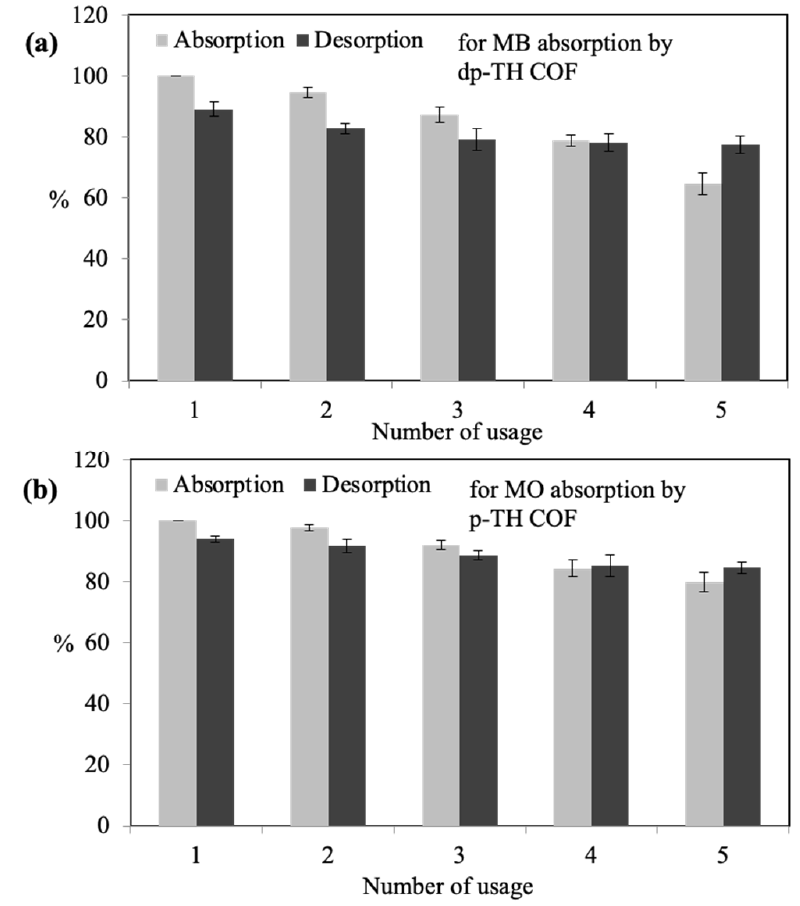
Figure 6. Reusability studies of ( a ) MB absorption/desorption by dp-TH COFs, and ( b ) MO absorption/desorption by dp-TH COFs. (Reaction conditions: 100 mL 25 ppm dye solutions, 0.05 g absor- bent, 500 rpm, room temperature for absorption; 100 mL 2.5 M NaOH, and HCl solutions, 500 rpm, room temperature for desorption).